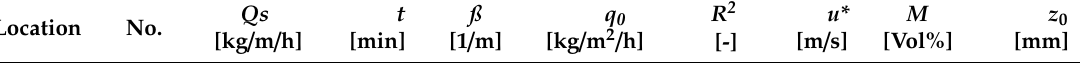
Table 3. Results of the total mass flux over the measuring duration, decay rate, extrapolated saltating sediment mass transport at the surface, correlation coe ffi cients of the regression analysis of the vertical wind profile (rounded values), shear velocity, moisture content, and aerodynamic roughness length. Qs Location No. Dune n / a, no sediment transport took place crest 12 Sand trapping fence 1